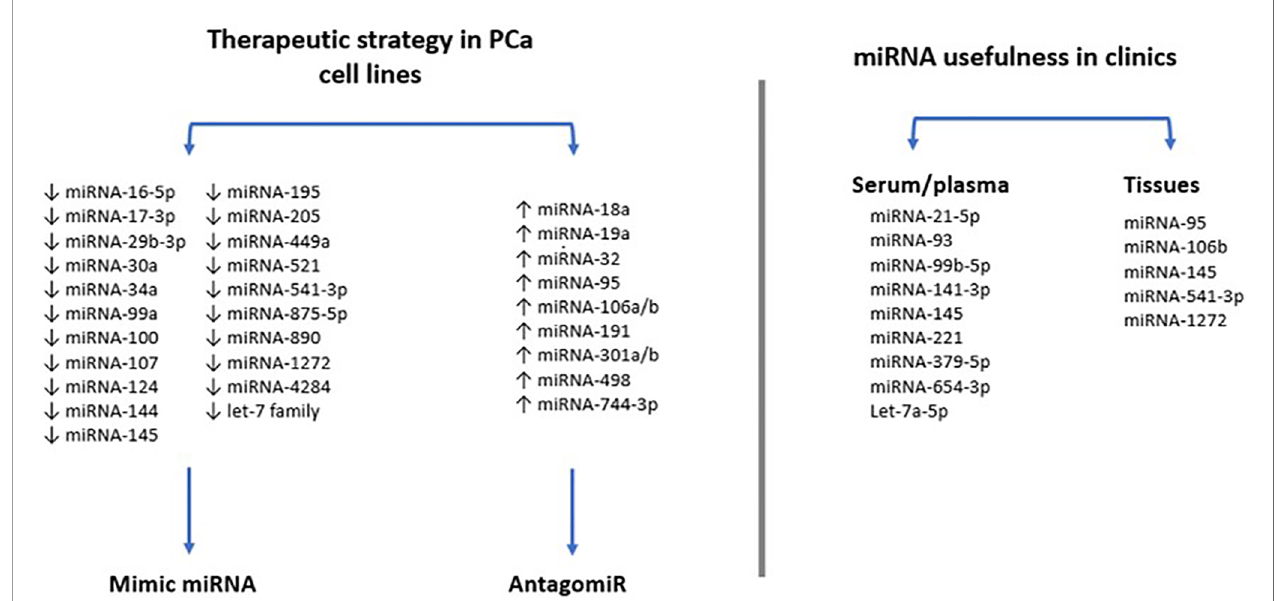
FIGURE 5 | Scheme illustration on the use of miRNAs as a therapeutic strategy in prostate cancer (PCa) cell lines. MiRNAs can be divided into mimic or antagomiR and some have also revealed to be useful in